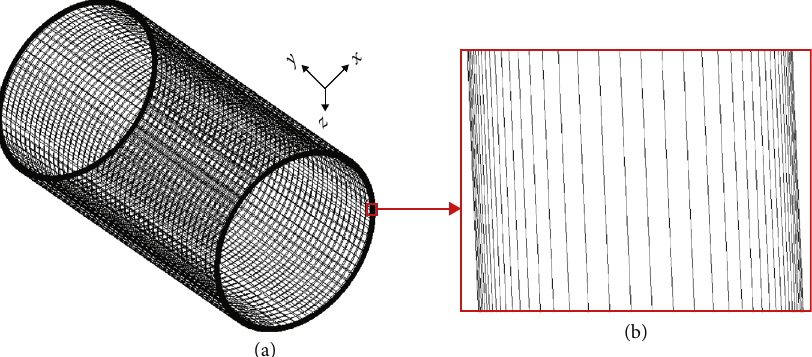
Figure 1: (a) Grid distribution of well annulus; (b) blow up of the grid distribution for the outlet of the well